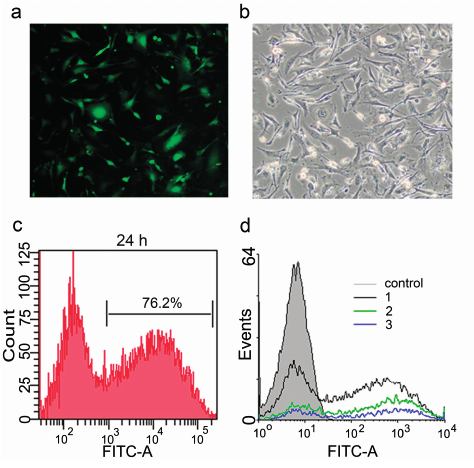
Figure 3. Transfection of mouse embryonic fibroblast (MEF) with green fluorescent protein (GFP) mRNA. Seeded cells in one well of a 24-well plate were transfected using 1 µg of mRNA of the green fluorescent protein according to the lipofection protocol ( a , b ); The microscopic fluorescence and bright field images (magnification 100×) of the cells 24 h after transfection, respectively; ( c ) Histogram for transfection efficiency analysis showed that more than 75% of the cells successfully expressed GFP after 24 h of lipofection; ( d ) Optimization of the transfected amount of mRNA revealed that 1 µg of mRNA (black line) achieved the highest expression value compared to 1.5 µg (green line) and 2 µg (blue line).